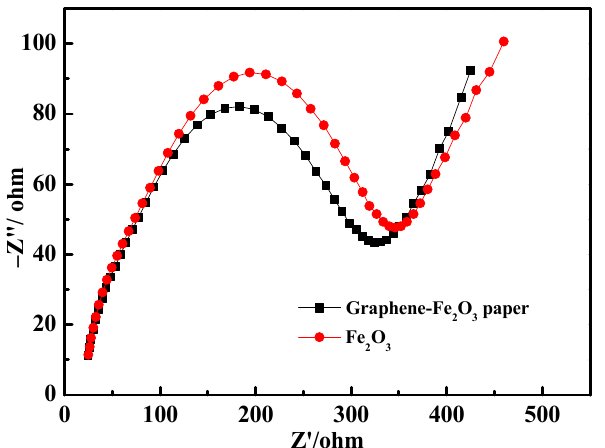
Figure 8. The EIS of the hybrid graphene-Fe 2 O 3 sheet anode and Fe 2 O 3 anodes before cycling (0.01–100 kHz). Embedded is the modeled equivalent circuit of the EIS. Table 2. The Nyquist diagram is fitted by the equivalent circuit.